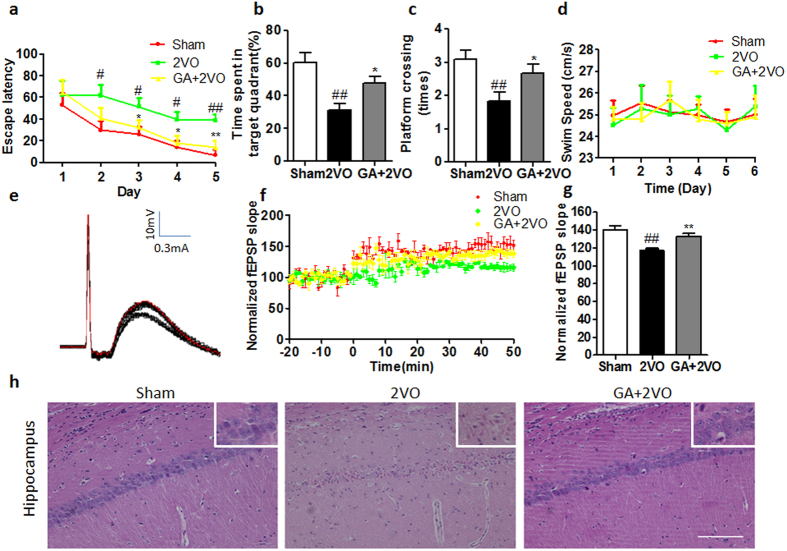
Effects of GA on cognitive deficits of rats induced by chronic cerebral hypoperfusion: behavioral, LTP and cellular level changes.(a) Average escape latency to find the target platform in MWM test. The 2VO group spent more time finding the hidden platform on day 2 (P < 0.05), day 3 (P < 0.05), day 4 (P < 0.05) and day 5 (P < 0.01) in the training phase than the sham-operated group, indicating the cerebral hypoperfusion significantly impaired spatial learning in rats. GA treatment significantly decreased the latent period to locating the escape platform compared with the PBS-treated 2VO group on days 3 (P < 0.05), day 4 (P < 0.05) and day 5 (P < 0.01) of training. n = 12 (b,c) The percentage of time spent in the target quadrant within 60 sec and platform crossing times in the probe trial. The 2VO group spent less time in the target quadrant and less numbers of platform crossing than the sham group (P < 0.01, P < 0.01 respectively). GA-treated rats spent more time in the target quadrant and more numbers of platform crossing than did the PBS-treated 2VO rats (P < 0.05, P < 0.05 respectively). (d) There was not significantly difference among the three groups in terms of the mean swimming velocity in MWM (P > 0.05). (e) Representative electrophysiological profile. (f,g) LTP levels and time course changes in fEPSP slope in three groups respectively. In 2VO group, the normalized slope of the fEPSP was significantly reduced compared with that in sham group (P < 0.01). However, GA could attenuate this change compared with that in 2VO group (P < 0.05). n = 8 (g) Representative photographs of tissue sections stained with H&E in the hippocampal CA1 area (magnification: 200×). Section from a sham-operated group shows intact neurons and well-preserved cell density. Section from the 2VO group shows neuronal loss with ischemic changes (neuronal cell loss, nuclei shrinkage and dark staining of neurons). Section from the GA group shows more or less intact neurons with intact chromatin. Scale bar = 50 μm, n = 4. The datas of average escape latency were analyzed with two-way repeated ANOVA and other datas were analyzed by one-way ANOVA; shown are the means ± SEM. (*P < 0.05 and **P < 0.01 vs 2VO group, #P < 0.05 and ##P < 0.01 vs sham group).